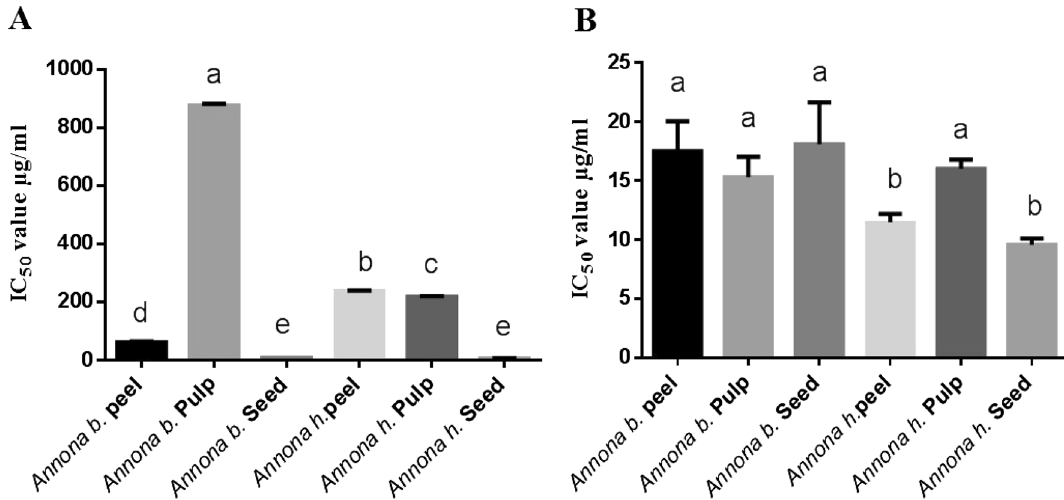
Figure 2. The antioxidant IC 50 values (µg/ml) of Annona b. and Annona h. Peel, pulp, and seed. DPPH ( A ) and ABTS ( B ). Values represent means ± SD (standard deviations) for triplicate experiments. IC 50 values (µg/ml) of ascorbic acid of DPPH and ABTS were 6.39 ± 0.04 and 8.75 ± 0.25, respectively. Values bearing the same letters showed no significant difference (* P < 0.05). The results are sorted in descending order: a < b < c < d < e.